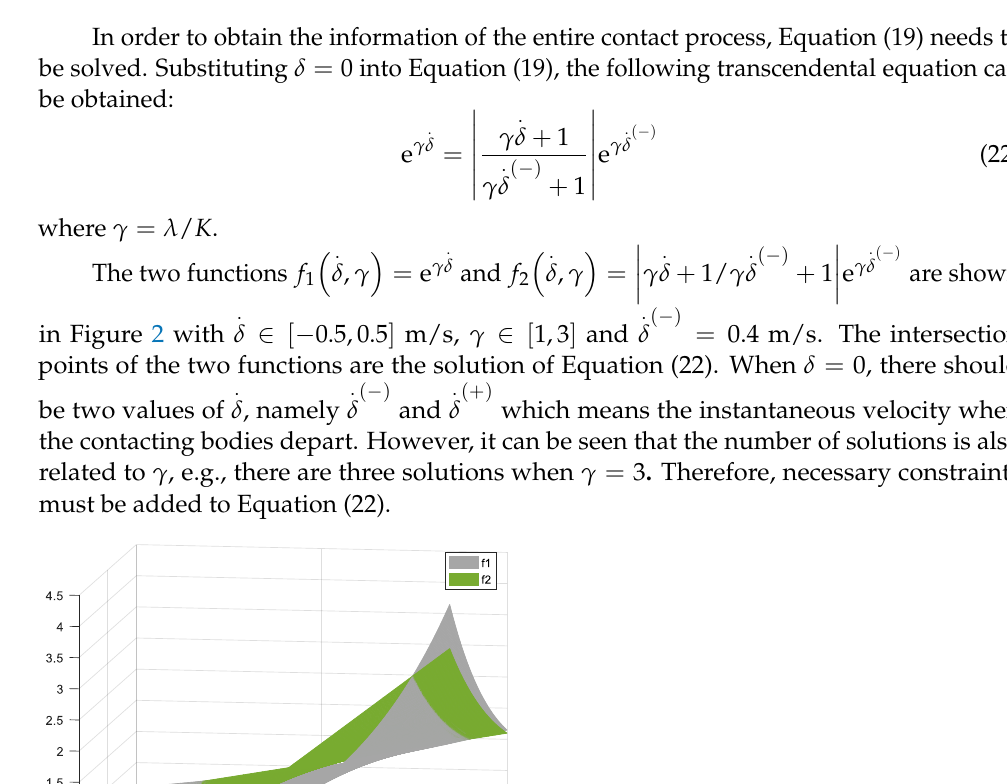
f and f with respect to  and δ . Figure 2. The surfaces of f 1 and f 2 with respect to γ and 1 2